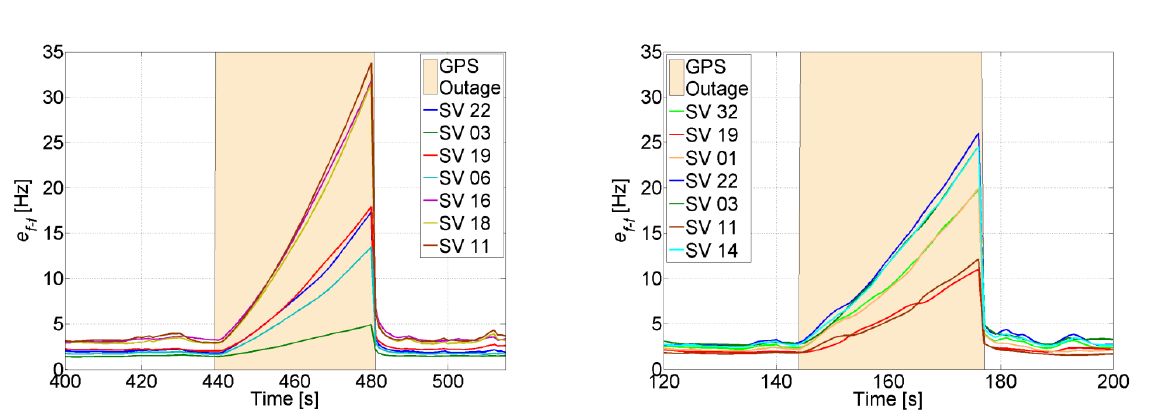
Figure 30. Feed-forward frequency uncertainty during Trajectory 1 ( left ) and Trajectory 2 ( right